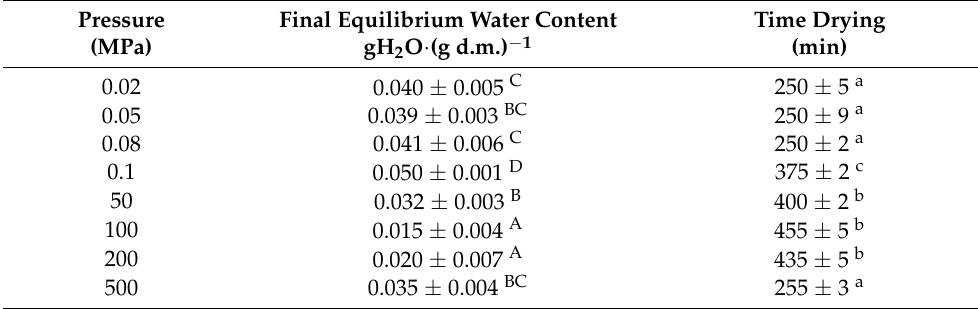
Table 1. Process and sample parameters in the obtained dried apples from osmotically dehydrated apples. Mean values marked with the same letter index (a–c) and (A–D) do not differ statistically significantly at the level of p =